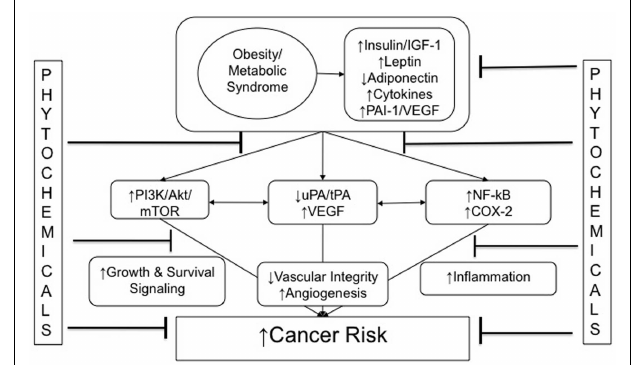
FIGURE 1 | Obesity and cancer: mechanistic targets for phytochemical interventions . An arrow preceding text denotes a directional effect (e.g., activity or concentration). Abbreviations: IGF-1, insulin-like growth factor-1; ApN, adiponectin; PAI-1, plasminogen activator inhibitor-1; tPA, tissue-type plasminogen activator; uPA, urokinase-type plasminogen activator;VEGF, vascular endothelial growth factor; PI3K, phosphoinositide-3-kinase; NF- κ B, nuclear factor κ B; COX-2, cyclooxygenase-2; EMT, epithelial-to- mesenchymal